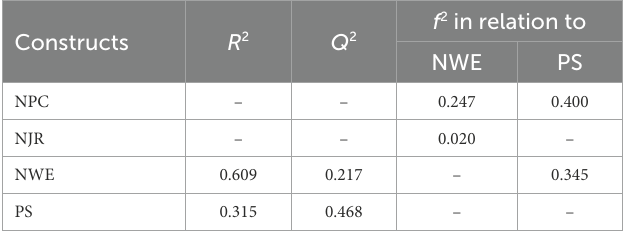
TABLE 8 The evaluation of measurement model fit.